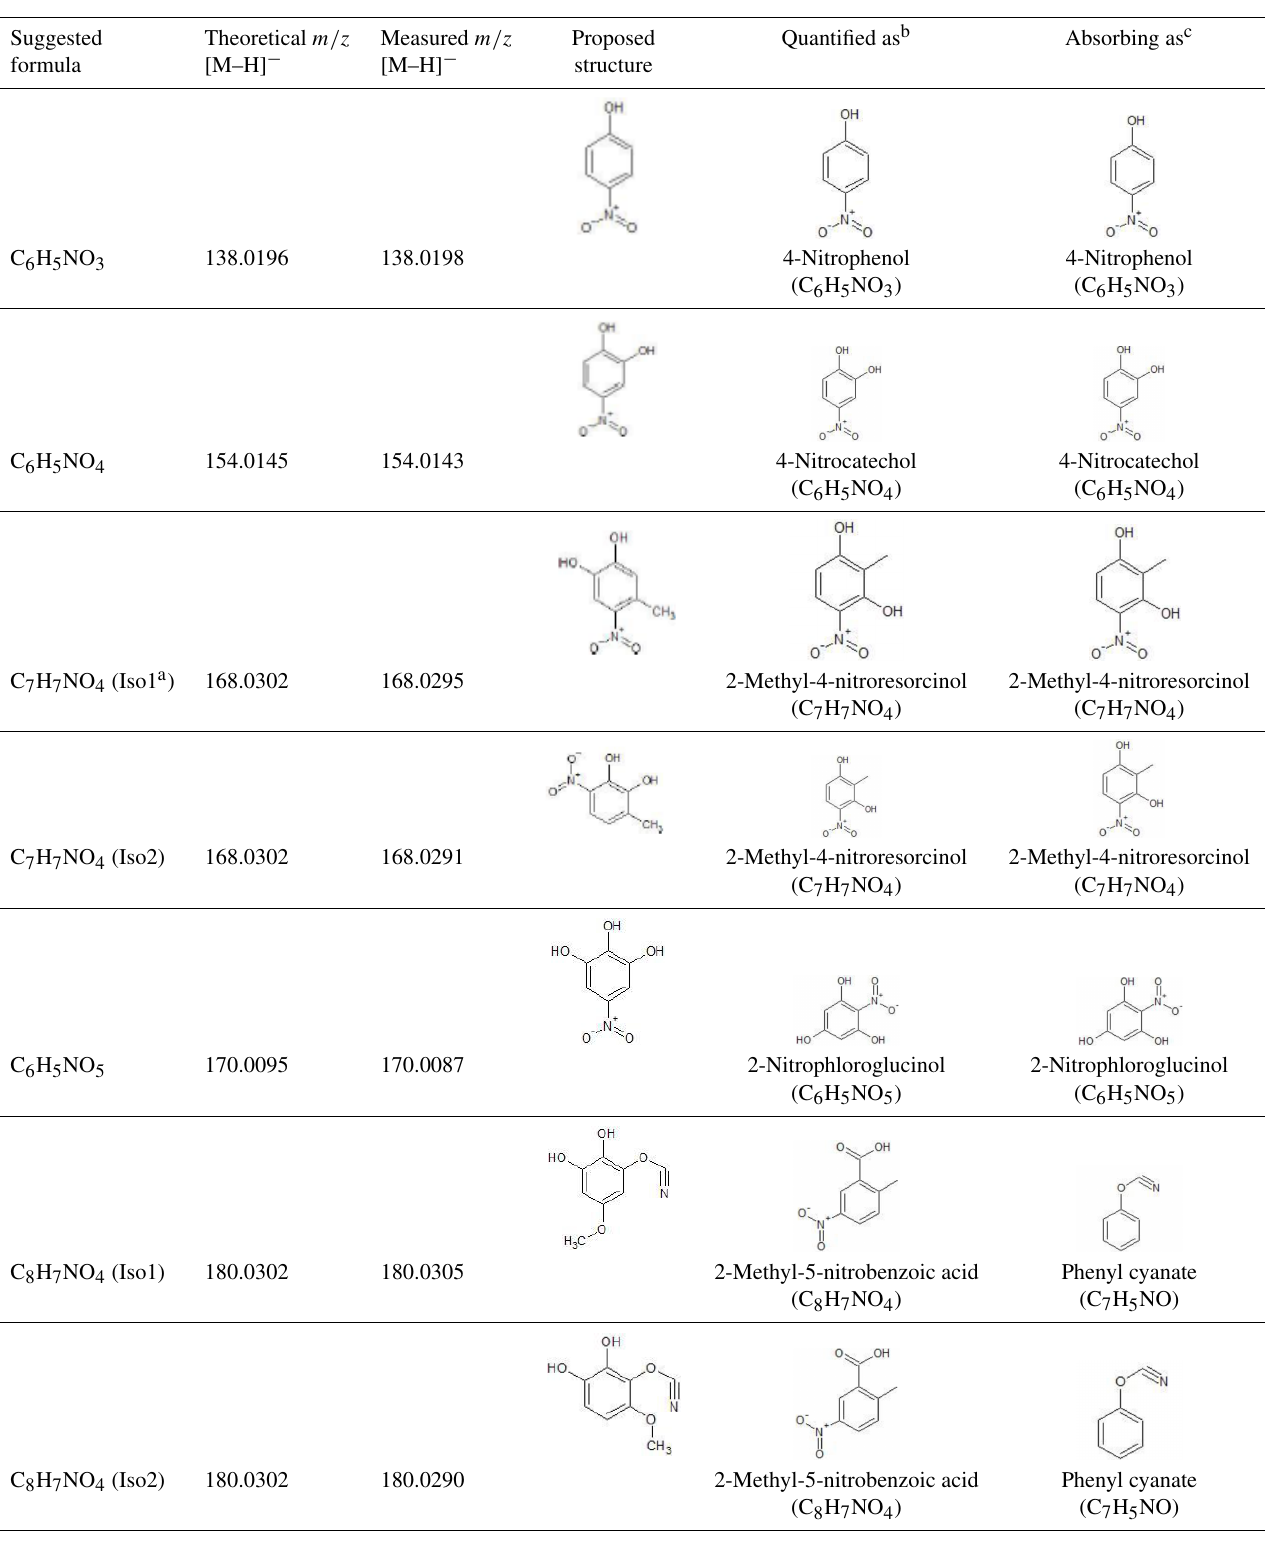
Table 2. Identified N-containing aromatic compounds by HPLC/ESI-Q-ToF-MS from laboratory biomass burning in this study.